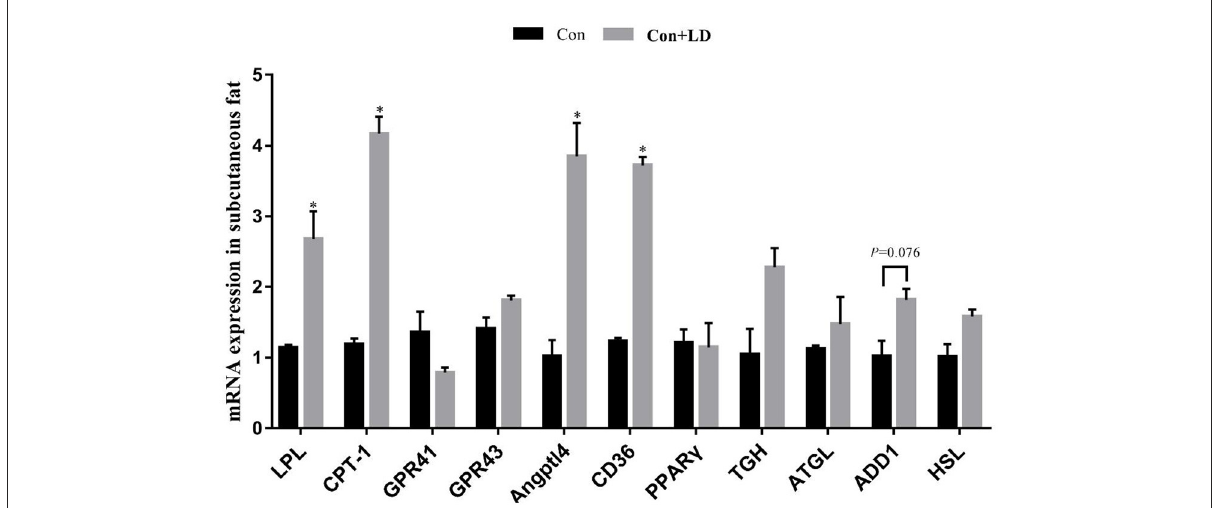
FIGURE6 Gene expression related to lipid metabolism in subcutaneous fat of growing-finishing pigs. Values for histogram are shown as Mean ± SEM, * P < 0.05. LPL , Lipoprotein lipase; CPT1 , Carnitine palmitoyltransferase 1; GPR41 , G protein-coupled receptor41; GPR43 , G protein-coupled receptor43; Angptl4 , Angiopoietin-like protein 4; CD36 , Cluster of differentiation 36; PPAR γ , Peroxidase proliferative receptor γ ; TGH , Triglyceride hydrolase; ATGL , Adipose triglyceride lipase; ADD1 , Adipocyte determination and differentiation-dependent factor 1; HSL , Hormone sensitive lipase; Con, basal diet; Con + LD, basal diet + 0.1 % L. delbrueckii .